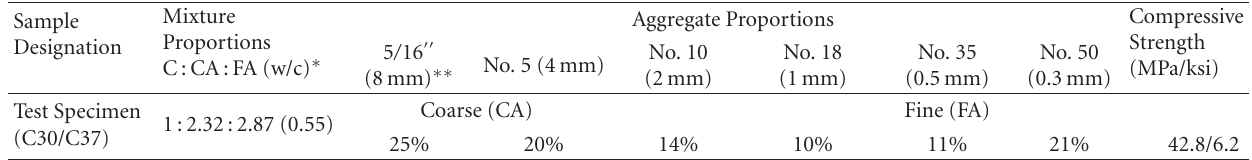
Table 1: Mixture proportions and some mechanical properties of concrete mixture.